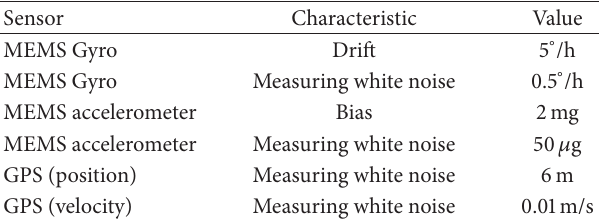
Table 1: Parameters of sensor